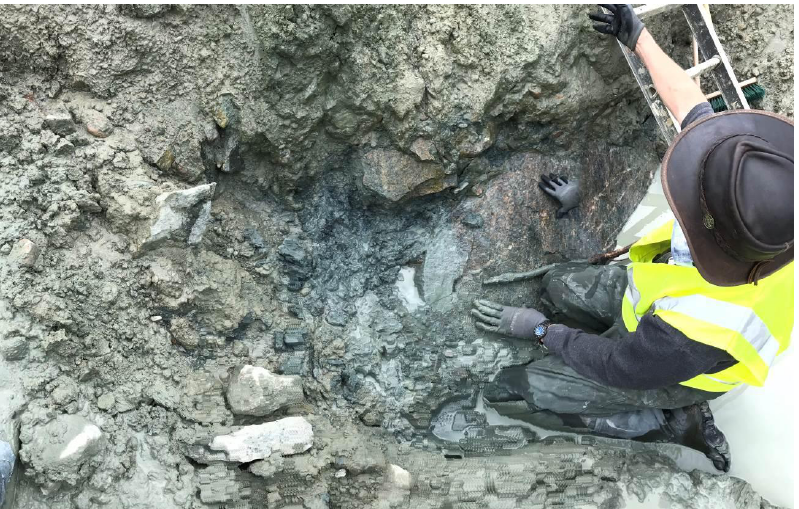
Figure A3. Photo of the collection of granite rocks found at approximately 6.3-m depth to the southeast of the center of the crater. The normal to the slab on the right is inclined at 30 ◦ to the vertical. In accord with our permit, the site was first filled with the rock and clay-sand mix- ture and topped with the peat layer. A wooden pole was driven into the peat to mark the center of the original 1985 impact crater. Three orange plastic stakes are located on elevated mounds at (1) 21.9 m to the south, (2) 26.76 m to the west, and (3) at 40.12 m at 61.5 ◦ north of west. Surveyor’s lines from each stake connect the stake to the center post in hopes that another expedition could easily find and re-excavate the